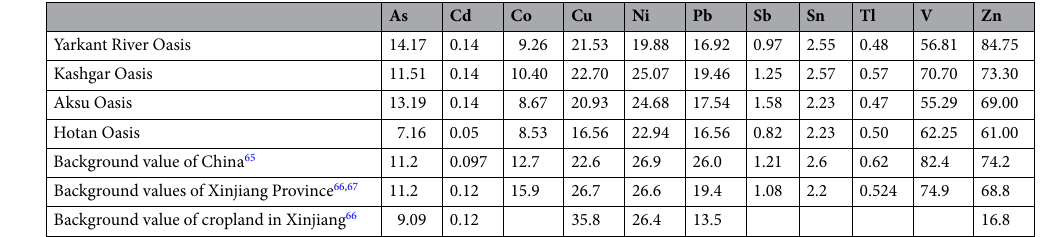
Table 2. GBVs of PTEs in oasis agricultural soils of the source region of the Tarim River.